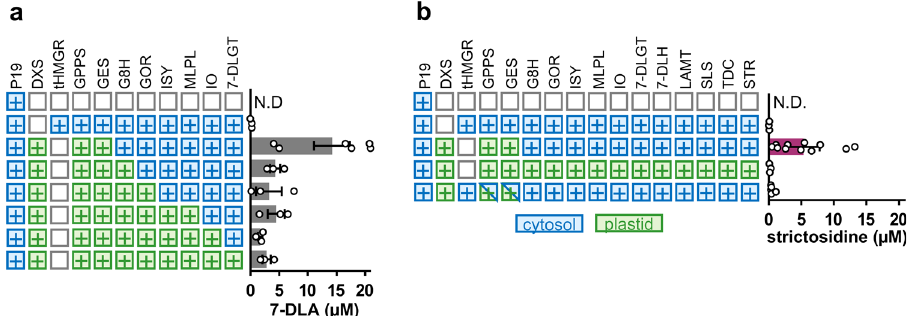
Fig. 6 Subcellular location of pathway enzymes affects product yields. Relocation of 7-DLA ( a ) and strictosidine ( b ) biosynthesis genes to the cytosol (blue) or the chloroplast (green) decreases product yield. tHMGR, truncated 3-hydroxy-3-methylglutaryl-coenzyme A reductase. Values and error bars represent the mean and the standard error of n ≥ 3 biological replicates (independent leaf Relative to control lines, plants with mutations in the Group A UGT, NbUGT94E7, no longer accumulated the peak putatively assigned as trihexosyl geranic acid ( m/z 699.2713, [M + HCOOH-H]) (Fig. 3, Supplementary Figs. 6 and 7). This UGT also lacks the GSS motif proposed to be important for de fi ning the loop structure of monoglucosyltransferases 37,39 – 44,46 . We additionally identi fi ed that, relative to control lines, four peaks were diminished or absent in plants with mutations in the Group G UGT, NbUGT85A73 (Fig. 3 and Supplementary Figs. 6 and 7). This UGT was previously reported as being active on geraniol 37 . [M + HCOOH-H]) and acetyl dihexosyl geraniol ( m/z 519.22425,